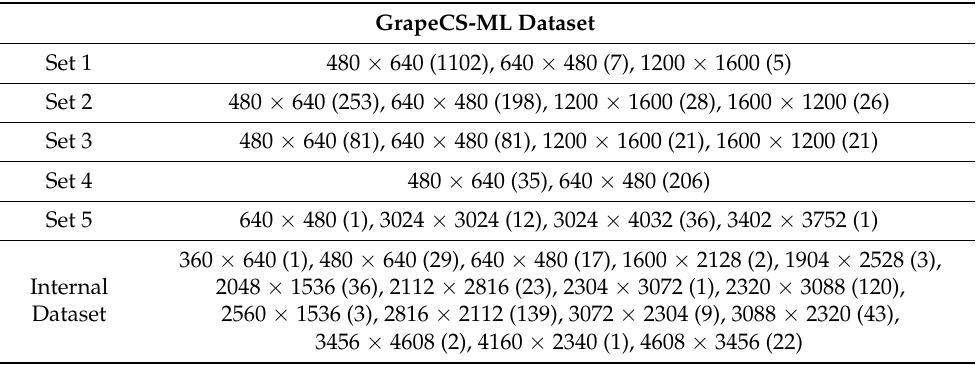
Table 3. Numerosity (in brackets) per different size of the images contained in the GrapeCS-ML dataset and in the internal dataset.